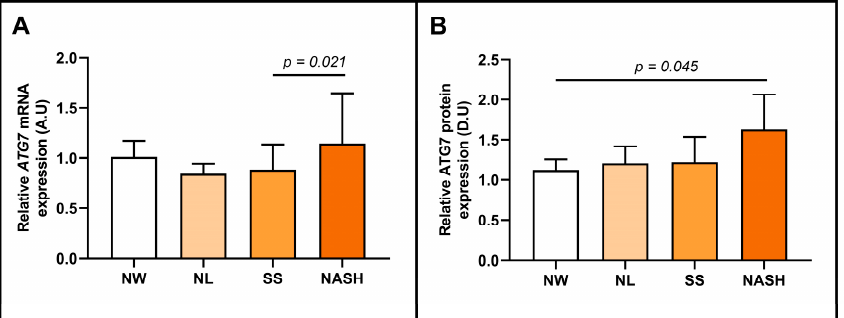
Figure 4. Differential relative ATG7 mRNA ( A ) and ATG7 protein ( B ) abundance in hepatic tissue between women with NW and MO subclassified as NL, SS, and NASH. mRNA expression analysis: NW ( n = 6), NL ( n = 11), SS ( n = 29), and NASH ( n = 32); and protein expression analysis: NW ( n = 5), NL ( n = 5), SS ( n = 5), and NASH ( n = 6). NW, normal weight; MO, morbid obesity; ATG7/ATG7, autophagy-related 7 gene/protein; SS, simple steatosis; NASH, nonalcoholic steatohepatitis; A.U, arbitrary units; D.U, densitometry units. Differences between groups were calculated using the Mann–Whitney test and p < 0.05 was considered statistically significant.